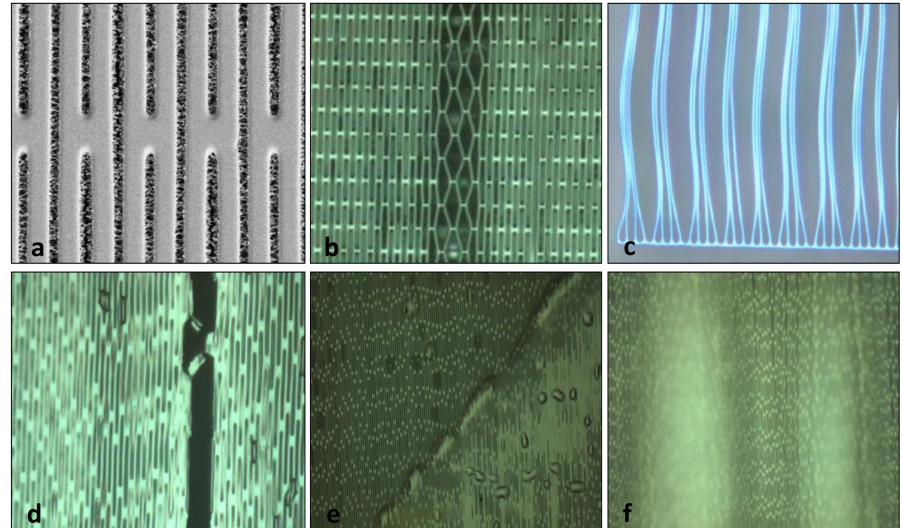
Figure 1. Defects during the microfabrication process using LIGA (“Lithographie, Galvanoformung, Abformung”) technology: ( a ) unwanted cross-links; ( b ) lamellae deformation; ( c ) high aspect ratio (HAR) structure collapse; ( d ) cracks; ( e ) bubbles; and ( f ) bad adhesion (identified by non-homogeneity in the focusing imaging at a microscopic level, showing parts of the image